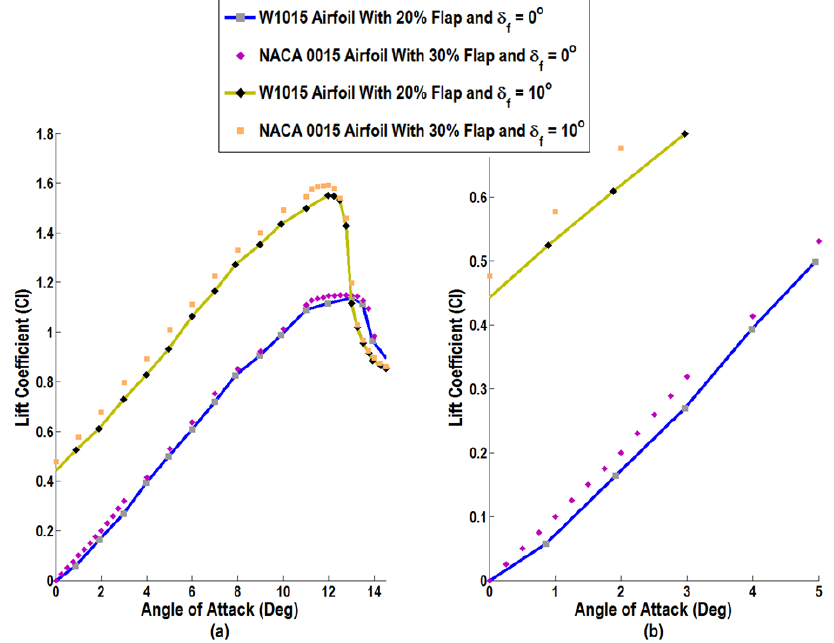
Figure 18. Lift increment at flap deflection of 10° and validation with the experimental data of Williamson [37].